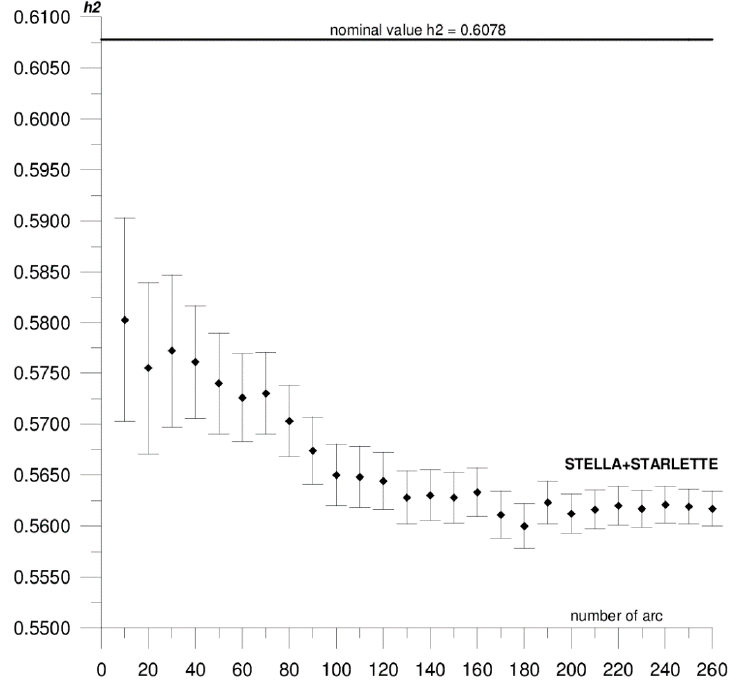
Figure 6. Sequential solution for the Mount Stromlo local h 2 parameter based on STELLA+STARLETTE data.